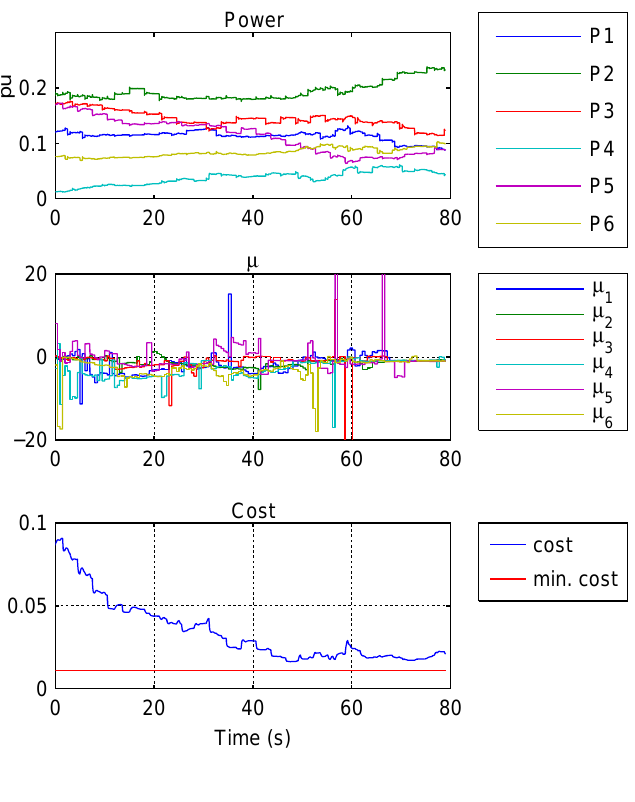
Figure 7. Performance of the decentralized control algorithm of Case